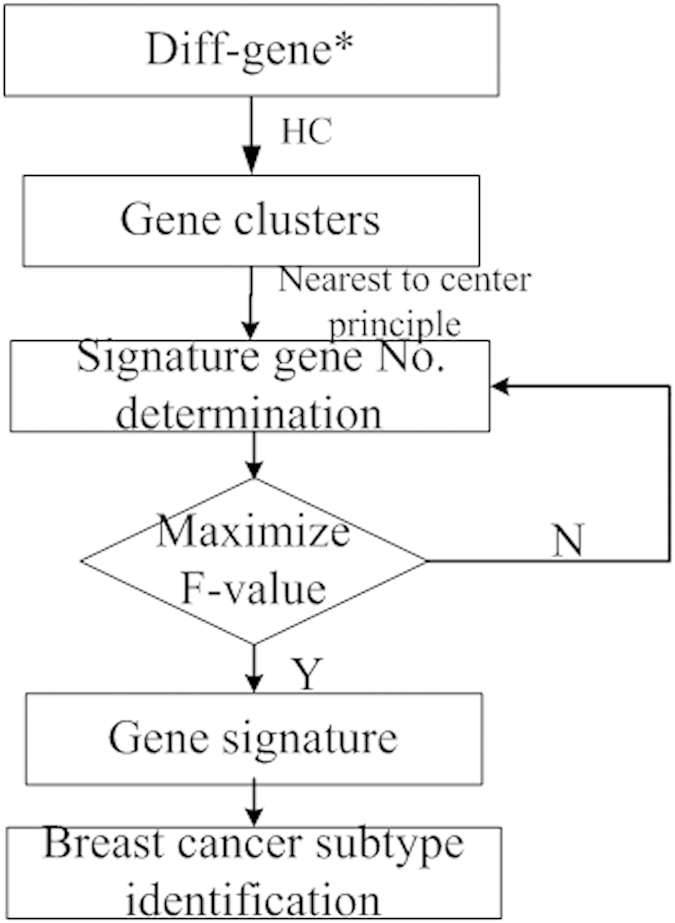
The process for signature gene identification.Genes marked by *are taken from4.